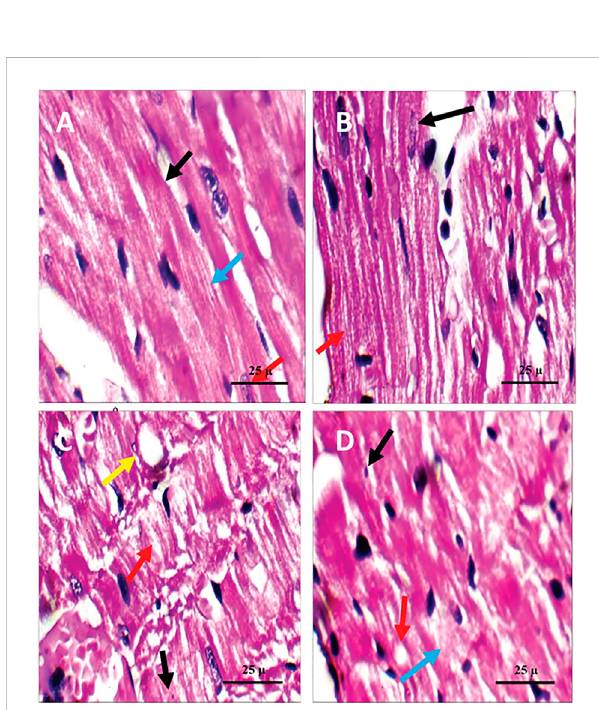
FIGURE 5 Microscopic pictures of the cardiac tissue of the studied rat groups stained with H&E. (A) Cardiac wall of the non-diabetic rats in the negative control group showing viable cardiac muscle fi bers with distinctcellborders(blackarrow),preservedcrossstriations(blue arrow), and central oval\elongated nuclei (red arrow). (B) Cardiac wall of the non-diabetic rats treated with the pomegranate peel extract showing cardiac muscle fi bers with centrally located nuclei (black arrow) and preserved cross striations (red arrow). (C) Cardiac wall of the diabetic rats in the positive control group showing scattered cardiac muscle fi bers with small pyknotic nuclei (black arrow), partial loss ofcross striations(redarrow),mildly congested interveningblood capillaries (blue arrow), and scattered cytoplasmic vacuoles (yellow arrow). (D) Cardiac wall of the diabetic rats treated with the pomegranate peel extract showing mildly scattered cardiac muscle fi bers with small pyknotic nuclei (black arrow), few scattered cytoplasmic vacuoles (blue arrow), and partial loss of cross striations (red